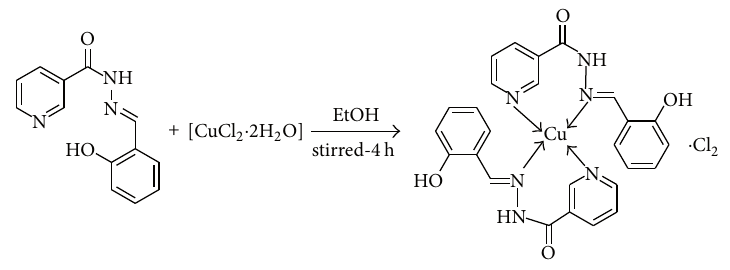
S 3: Route for the synthesis of the copper complex.